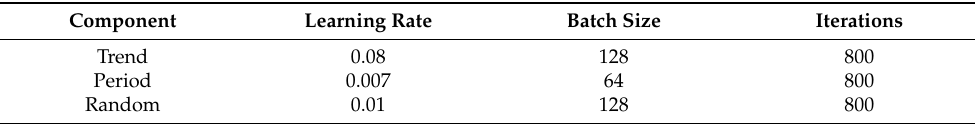
Table 3. Training parameters.